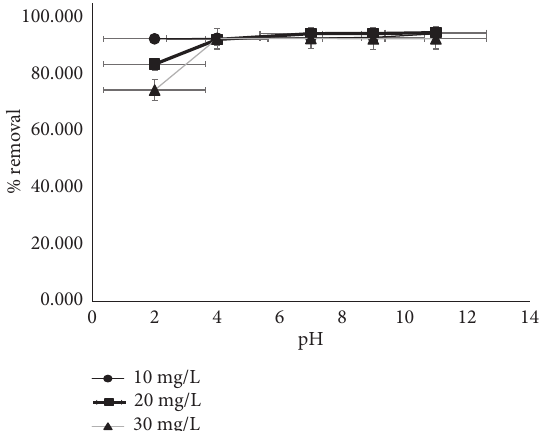
Figure 10: Effect of solution pH on the sorption of MB onto GBL.